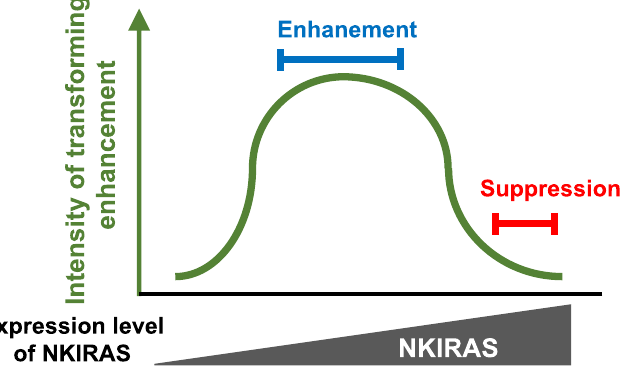
Figure 7. NKIRAS exhibits a “bell-shaped” expression level-dependent enhancing effect on the oncogenic Ras mutant-provoked oncogenic signals. NKIRAS2 exhibits a biphasic bell-shaped enhancing effect on RAS-mutant- provoked oncogenic